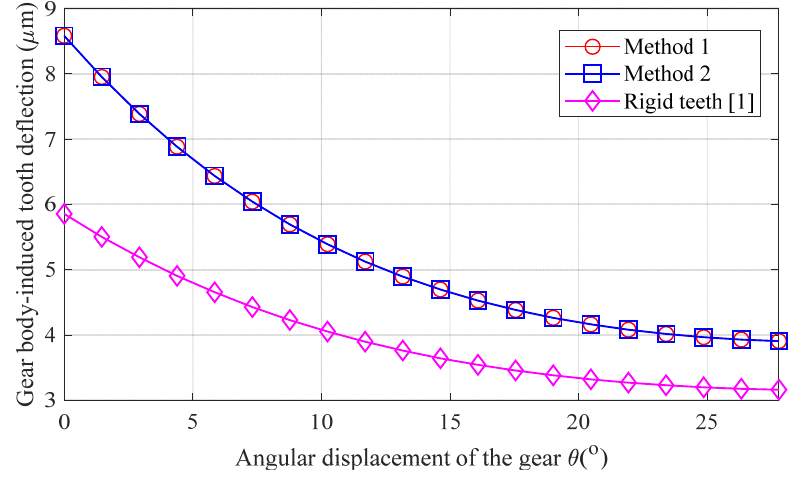
Figure 4. Comparison of three methods for calculating gear body-induced tooth deflection.